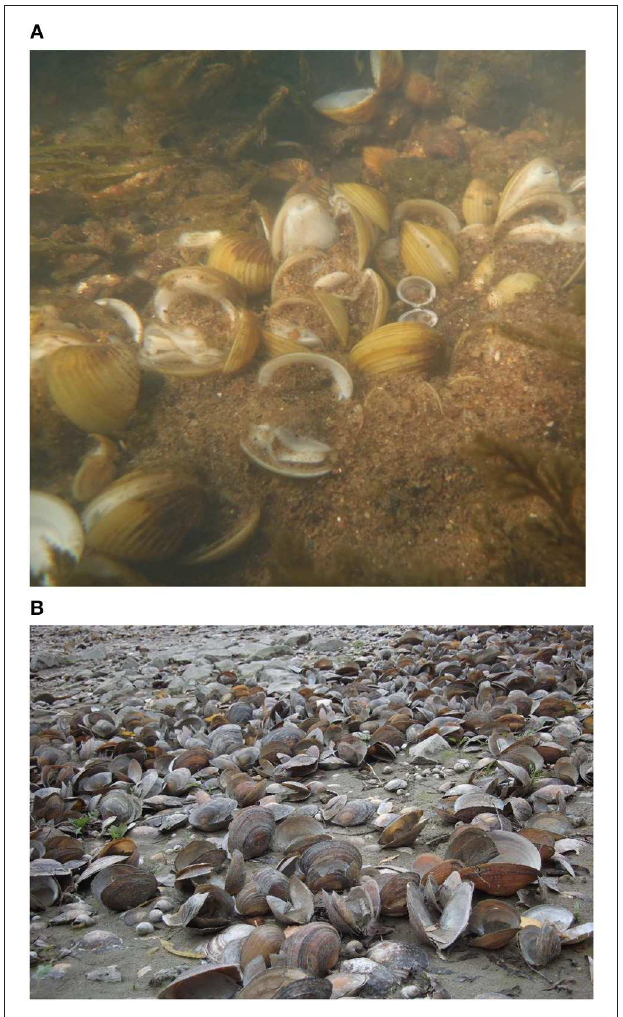
FIGURE 2 | (A) Corbicula die-off in Georgia USA caused by a summer drought, described in McDowell et al. (2017). Note the presence of soft tissue. (B) Sinanodonta woodiana die-off in the Danube River (Hungary) after a drought in 2011. Described in Bódis et al. (2014a).